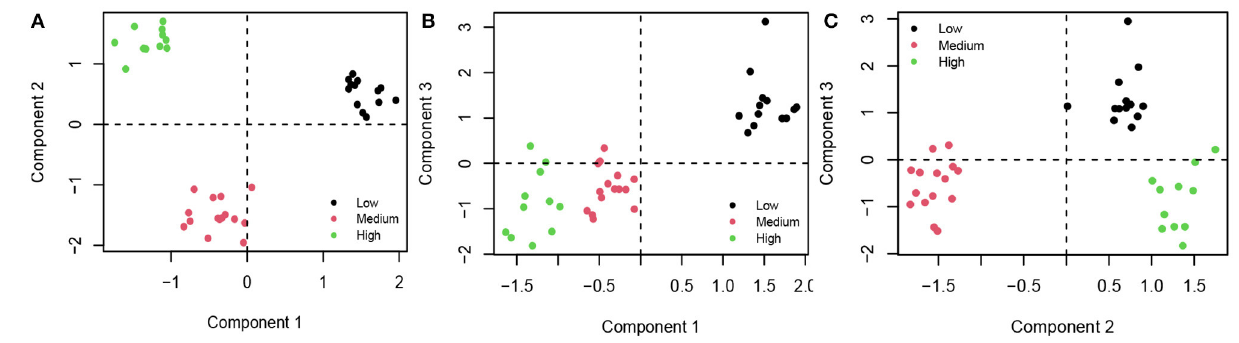
FIGURE 1 | (A) Group distribution of the first and the second components; (B) Group distribution of the first and the third components; (C) Group distribution of the second and the third components. Black, countries that adopted Low Stringency Index; red, countries that adopted Medium Stringency Index; green, countries with High Stringency